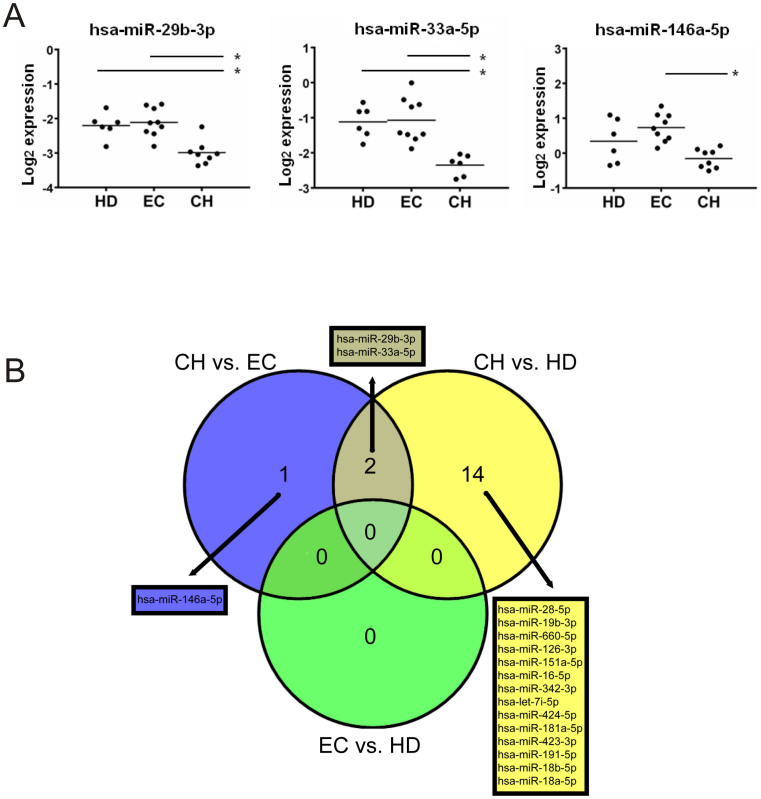
Differentially-expressed miRNAs.(A) Dot plot showing miRNAs differentially expressed between EC and CH. Each dot indicates the individual level of expression and the line is representing the mean of the group. Asterisks indicate a q value ≤ 0.05. (B) Venn diagram showing the overlapping of the differentially expressed miRNAs. HD: healthy donors, EC: elite controllers, CH: chronic HIV.